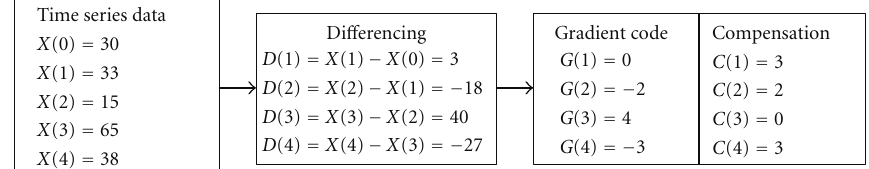
Figure 2: An example of generating gradient